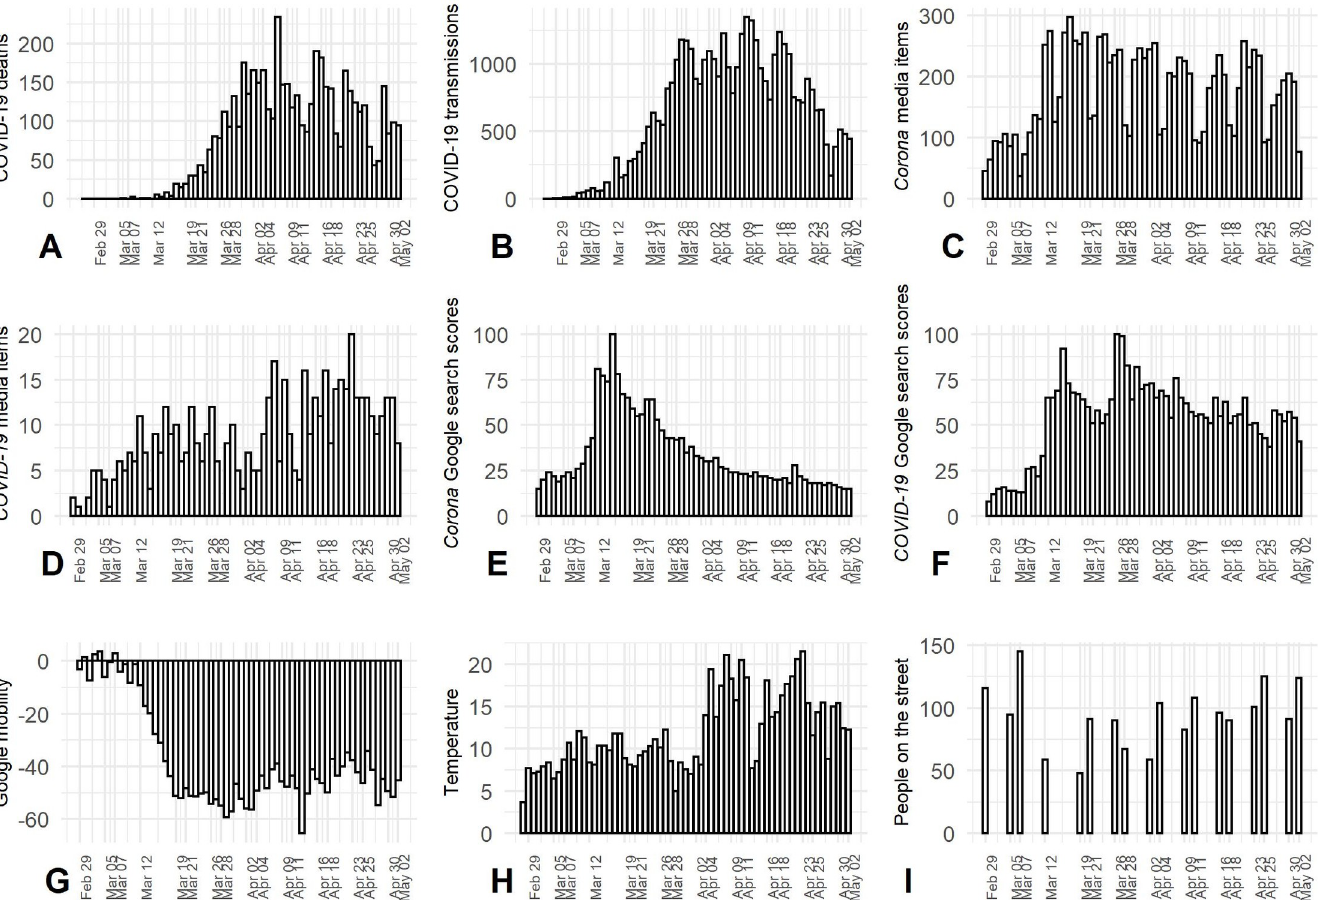
Fig 1. Covariates over time. The panels display time trends in (A) COVID-19 deaths, (B) COVID-19 transmissions, (C, D) media items, (E, F) Google search scores, (G) compliance with stay-at-home-directives (Google mobility), (H) temperature, and (I) the number of people on the street.